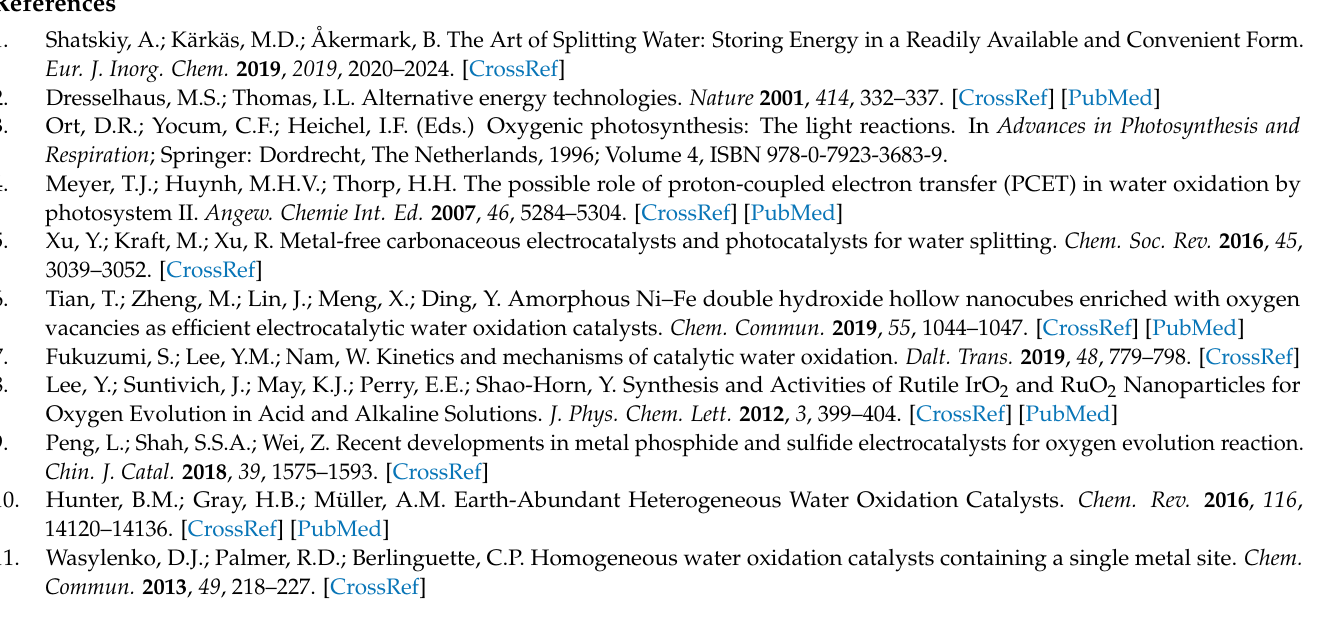
Na 3 [Ru 2 ( µ - CO 3 ) 4 ] and 0.10 M NaHCO 3 (pH 8.3), Figure S16: i d at E pc of − 0.50 V vs. v 1/2 in 1.0 mM Na 3 [Ru 2 ( µ - CO 3 ) 4 ] and 0.10 M NaHCO 3 (pH 8.3), Figure S17: i d at E pc of − 0.75 V vs. v 1/2 in 1.0 mM Na 3 [Ru 2 ( µ - CO 3 ) 4 ] and 0.10 M NaHCO 3 (pH 8.3), Figure S18: CVs of 5.0 mM Na 3 [Ru 2 ( µ - CO 3 ) 4 ] in 0.10 M NaHCO 3 (pH 8.3) highlighting the Ru III Ru II /Ru II Ru II couple, Figure S19: Absorption spectra of 1.0 mM Na 3 [Ru 2 ( µ - CO 3 ) 4 ] in presence and absence of 0.10 M NaHCO 3 , Figure S20: A qualitative MO diagram of the metal-metal bonding for an M 2 X 8 (M = transition metal and X is halide) species of symmetry D 4h . The electron distribution shown is that for [Ru 2 ( µ - CO 3 ) 4 ] 3+ , Figure S21: The chronoamperometry (CA) of 1.0 mM Na 3 [Ru 2 ( µ - CO 3 ) 4 ] in 0.10 M NaHCO 3 at pH 8.3 for 15 h at a potential of 1.6 V vs. NHE, Figure S22: Absorption spectra before and after chronoamperometry of a solution containing 1.0 mM Na 3 [Ru 2 ( µ - CO 3 ) 4 ], 0.10 M NaHCO 3 at 1.6 V vs. NHE for 15 h, Figure S23: Comparison of the electronic absorption spectra of 1.0 mM Na 3 [Ru 2 ( µ - CO 3 ) 4 ], 0.10 M NaHCO 3 in presence and absence of NaHCO 3 , Figure S24: The SEM image of the GC electrode before and after chronoamperometry, Figure S25: Successive CVs of 1.0 mM Na 3 [Ru 2 ( µ - CO 3 ) 4 ] in 0.10 M NaHCO 3 (pH 8.3) at a scan rate of 50 mV s − 1 , Figure S26: Tafel plot in presence of bicarbonate. LSV is recorded in 1.0 mM Na 3 [Ru 2 ( µ - CO 3 ) 4 ] in 0.10 M NaHCO 3 at pH 8.3 at a scan rate of 50 mV . s − 1 , Figure S27: Tafel plot under neutral condition. LSV is recorded in a solution containing 1.0 mM Na 3 [Ru 2 ( µ - CO 3 ) 4 ] in 0.20 M NaClO 4 at pH 7.0 at a scan rate of 50 mV . s − 1 , Figure S28: CVs of 1.0 mM Na 3 [Ru 2 ( µ - CO 3 ) 4 ] in 0.10 M NaHCO 3 at pH 8.3 at various scan rates, Figure S29: CVs of 1.0 mM Na 3 [Ru 2 ( µ - CO 3 ) 4 ] in 0.20 M NaClO 4 at pH 7.0 at various scan rates, Figure S30: A Plot of i c / i d vs. v − 1/2 for a solution containing 1.0 mM Na 3 [Ru 2 ( µ - CO 3 ) 4 ] in 0.20 M NaClO 4 (pH 7.0). The i c is taken at 1.56